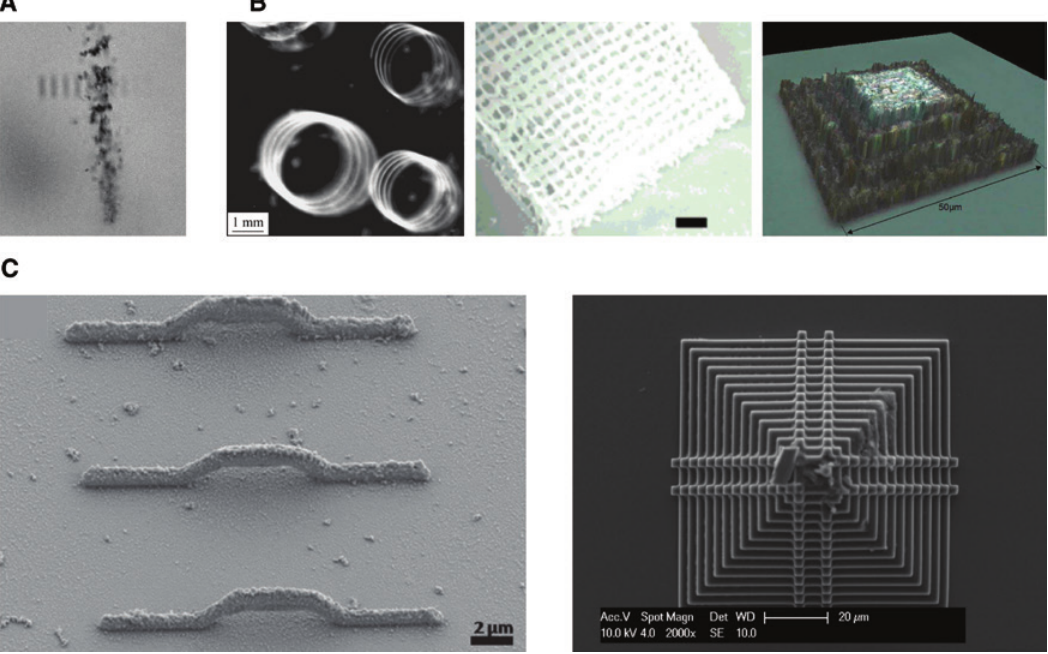
Figure 7: 3D metallic